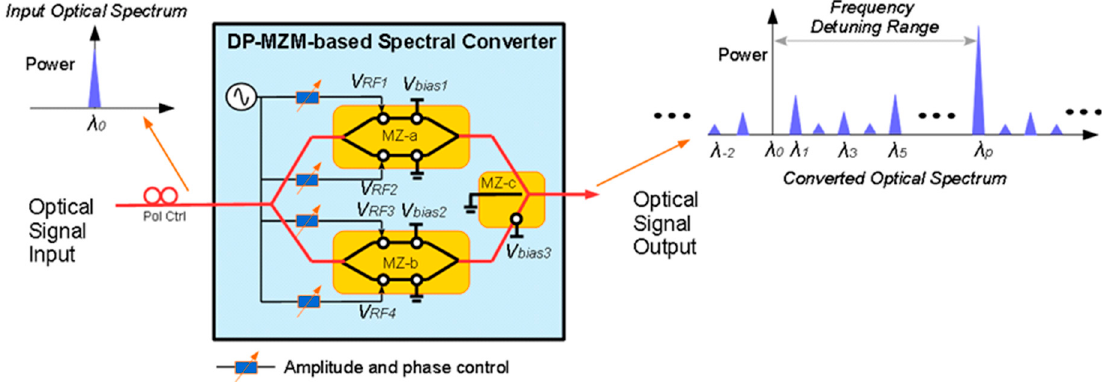
Figure 11. Spectral converter structure.